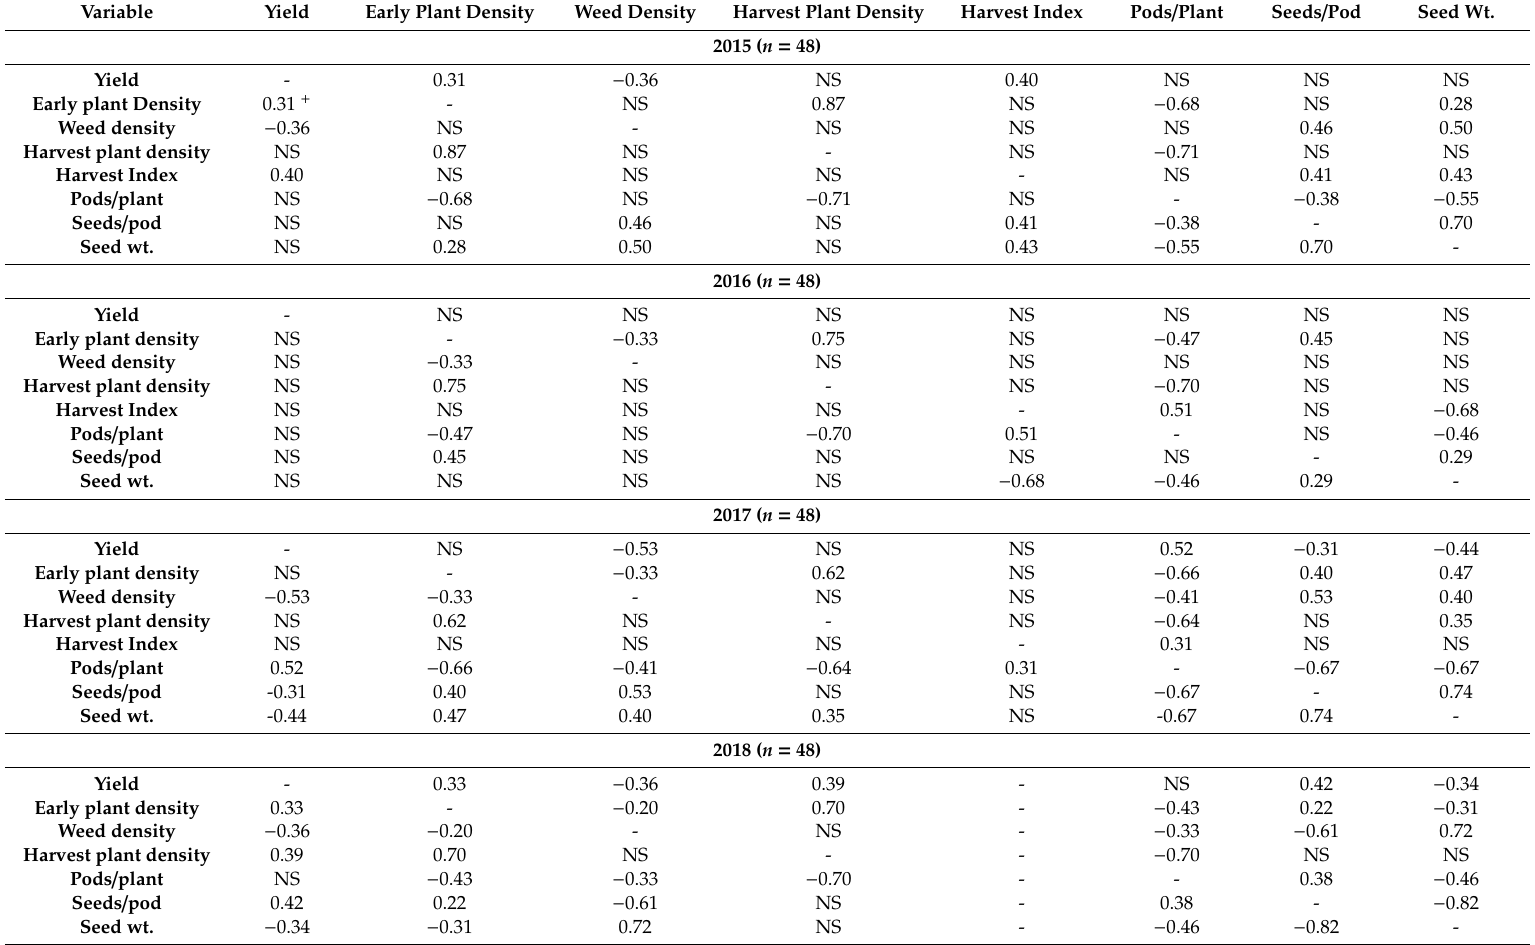
Table 4. Correlations ( r -values) among seed yield, early plant density, weed density, harvest plant density, pods / plant, seeds / pod and seed weight of soybean from 2015 to 2018 at a University Research Farm in central New York,